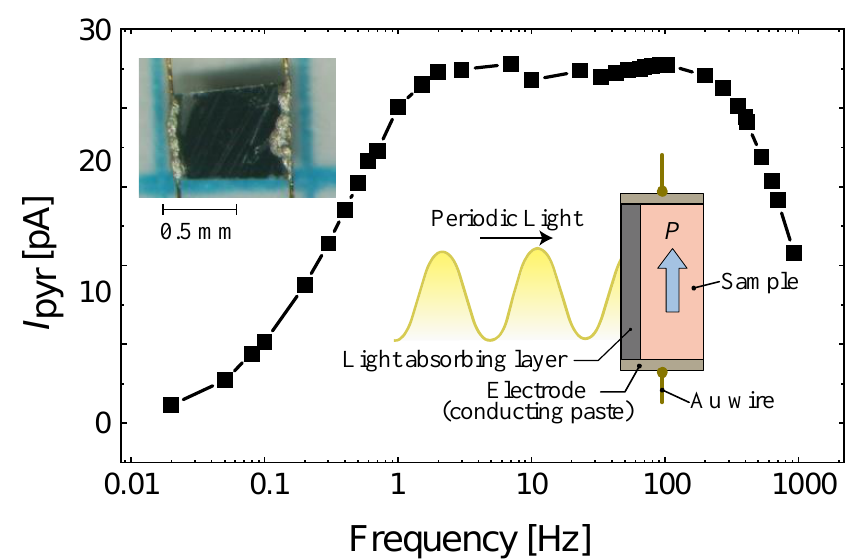
Figure 2. Frequency dependence of the pyroelectricity of LiNbO 3 measured using the temperature modulation method. The upper left inset is the photograph of the front surface of the sample coated with the light-absorbing layer. The inset in the center sketches the experimental layout.